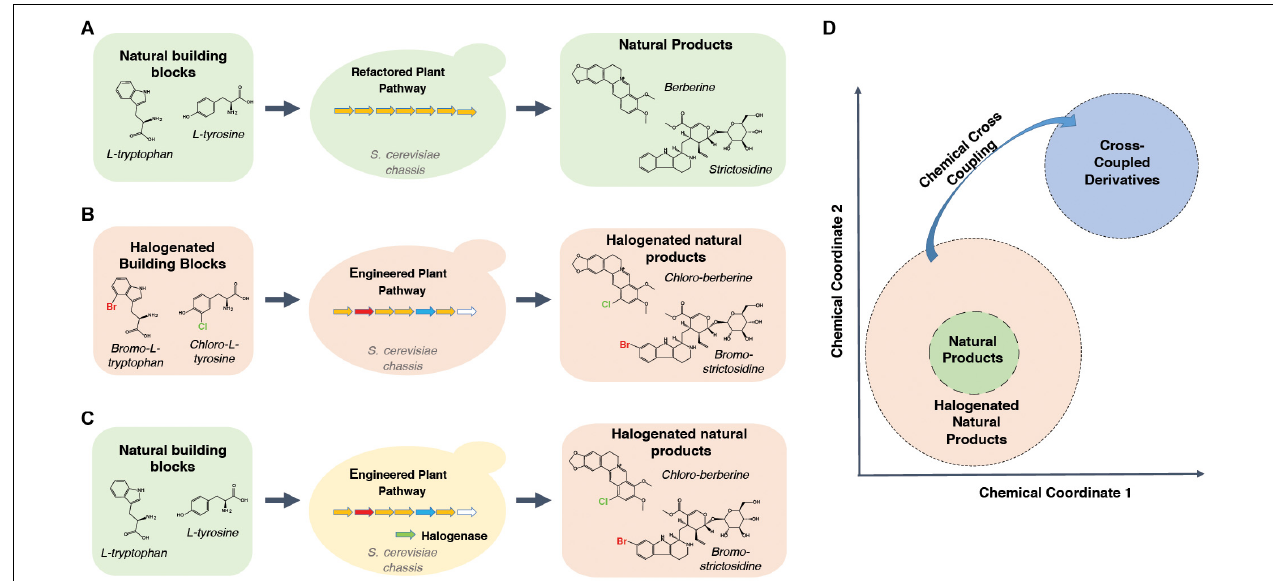
FIGURE 1 | Deploying synthetic biology to access novel regions of chemical space. (A) Readily available bulk feedstocks can be fed to yeast strains hosting refactored plant biosynthetic pathways. Natural products can then be extracted from fermentation broth. (B) Engineering of the plant biosynthetic pathway within the yeast chassis can allow or improve turnover of halogenated substrate analogs. Halogenated natural product scaffolds can be extracted from the fermentation broth. Promiscuous or engineered enzyme variants in engineered plant pathways are colored by red, blue and white arrows in the middle panel. (C) Introduction of halogenases can yield halogenated products from natural substrates. Promiscuous or engineered enzyme variants in engineered plant pathways are colored by red, blue and white arrows in the middle panel. Halogenase is depicted by a green arrow. (D) Schematic depicting the halogen derivatives surrounding natural product scaffolds in a hypothetical chemical space in which more similar compounds appear closer together. Halogens can facilitate targeted cross-coupling reactions that allow “hopping” to entirely new and chemically distinct regions of chemical